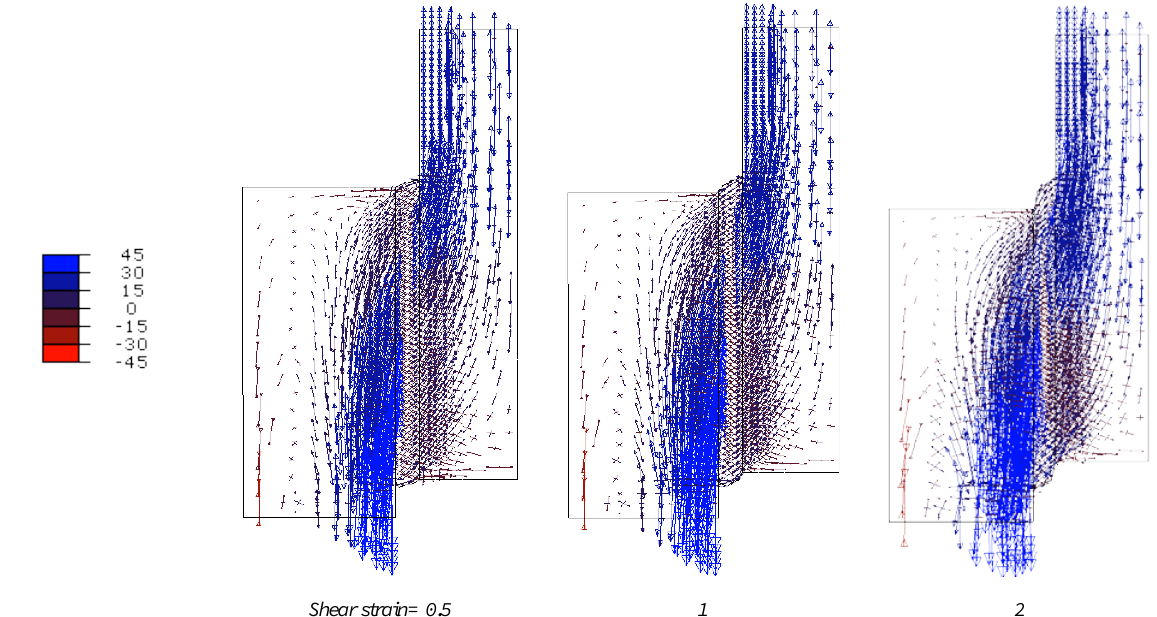
Fig. 7 Evolution of principal stresses (legend in [MPa]) in the M0C model (ABAQUS, 1/4 specimen), with δ f =1.5mm and t 0 =8MPa the CZM